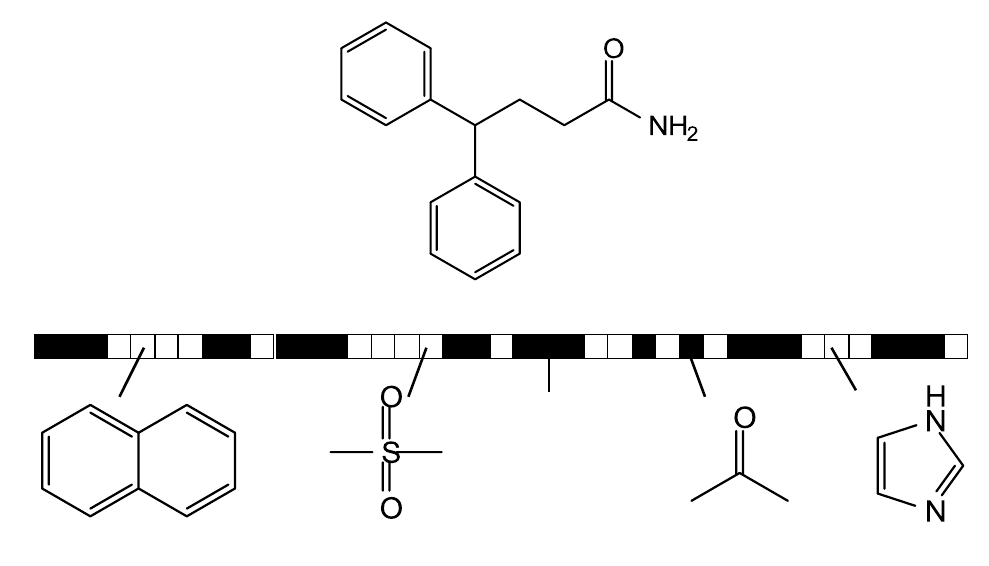
Figure 4. Schematic substructural fingerprint. A substructural fingerprint consists of a predefined set of substructural features represented by specific positions in a binary string. If a feature is present in a molecule the bit is set on in its fingerprint; otherwise it is set off. The bit pattern is illustrated by the bar where each square corresponds to a specific substructural feature, as indicated for five different fragments. The molecule shown at the top contains two of the five fragments. For these fragments, the corresponding bits are set on (filled square), whereas the bits for the three other substructures that do not occur in the molecule are set off (empty